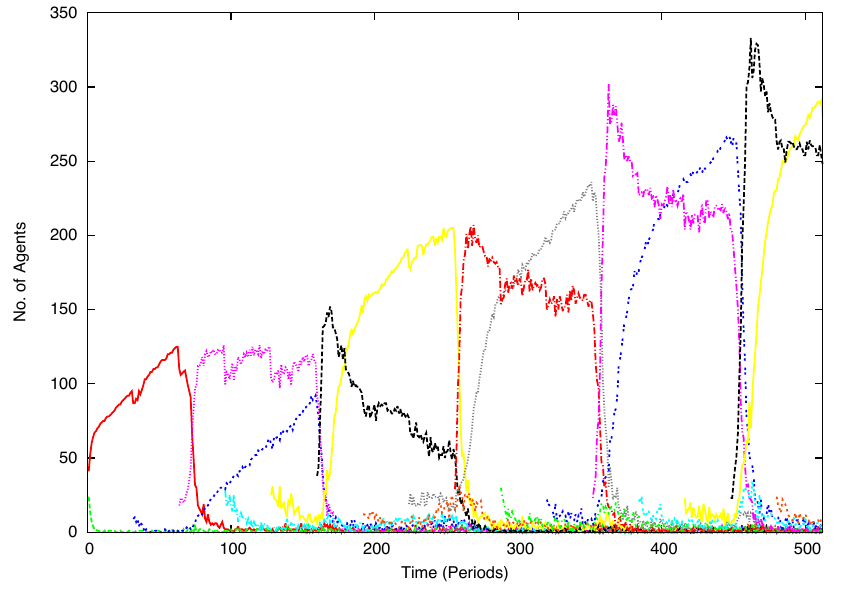
Figure 6. Development of the number of adherents to the different institutions (shown in different colors) for ↵ = 2 . 0